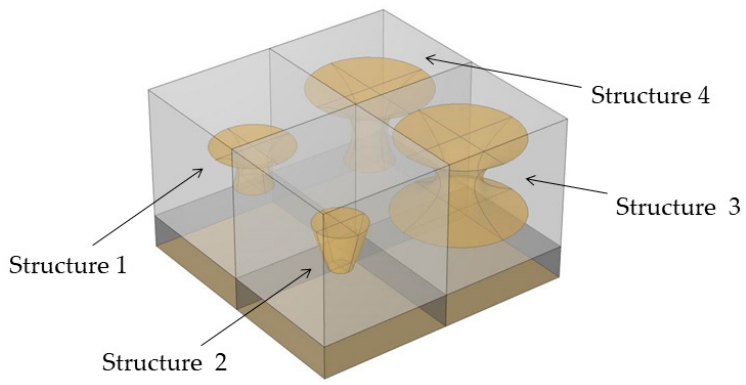
Figure 11. Schematic diagram of the parallel model.